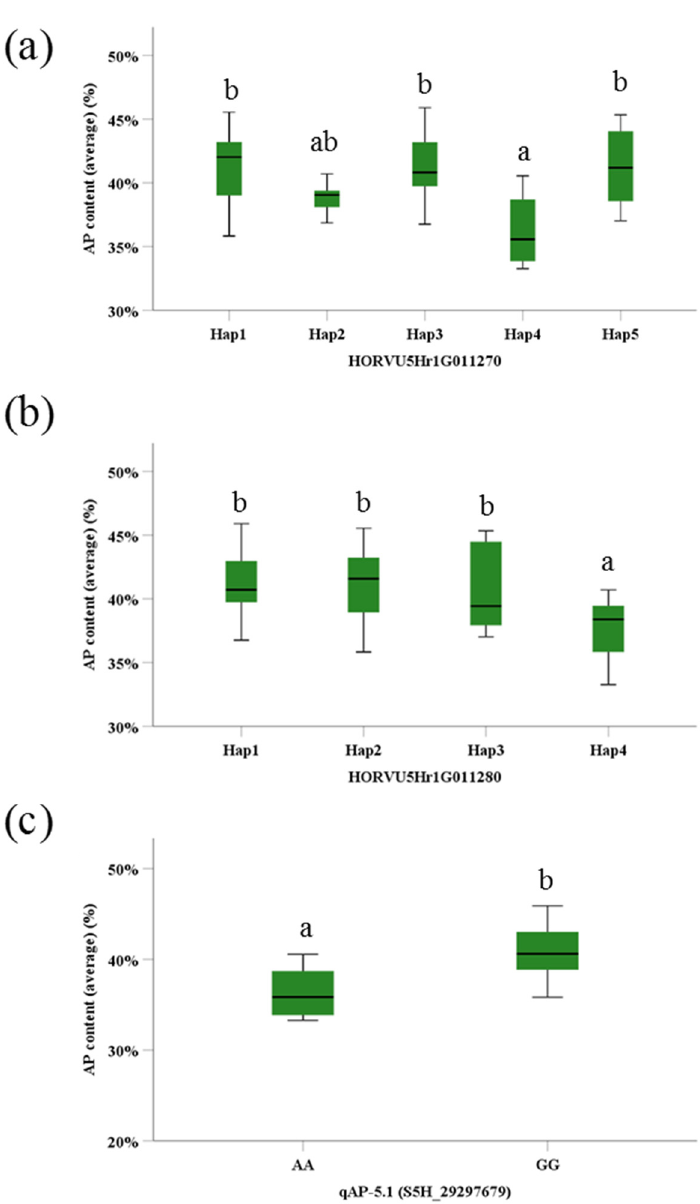
Figure 4. Haplotypes and Phenotypic differences of AP accumulation based on the largest explanation of phenotypic variation. ( a ) HORVU5Hr1G011270 resulted in five haplotypes depending on the polymorphism of 11 SNPs. ( b ) HORVU5Hr1G011280 resulted in four haplotypes depending on the polymorphism of 5 SNPs. ( c ) The average data of 100 barley accessions which was divided into two groups of AA and GG genotypes according to QTL qAP-5.1 (S5H_29297679). Different letters represent the significant differences ( p < 0.05).